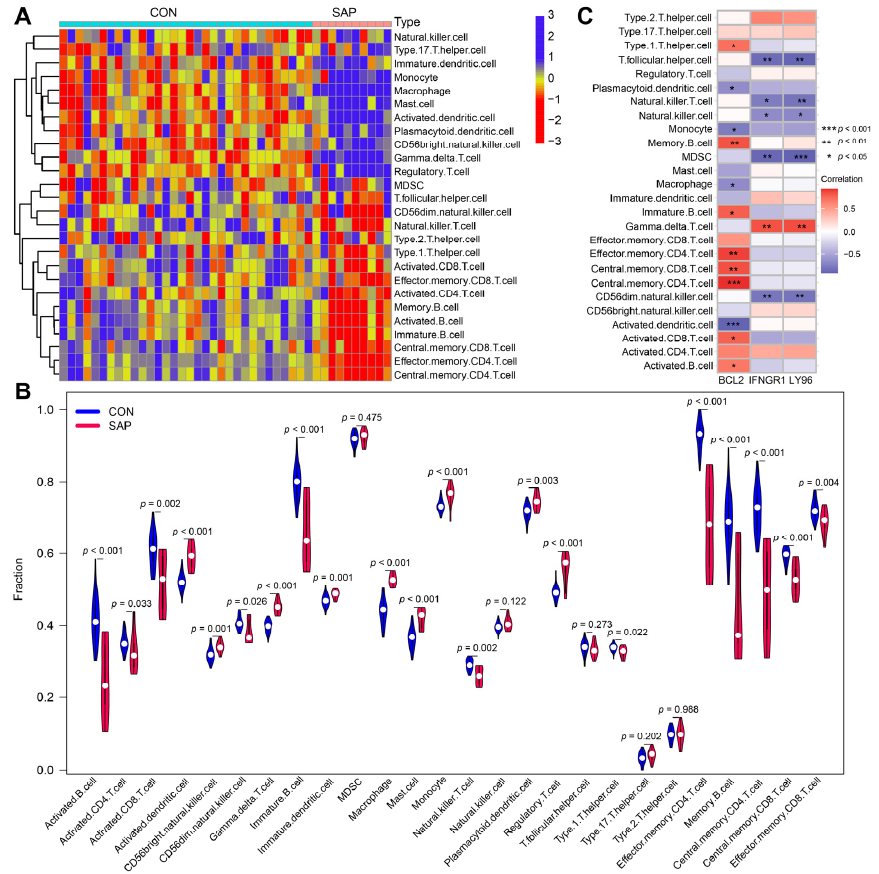
Figure 6. Analysis of immune in fi ltration in SAP patient samples and its correlation with hub genes using ssGSEA. ( A ) Heat map showing the immune scores of 26 immune cells. Red indicates immune cell in fi ltration and blue indicates suppressed immune cells. ( B ) Violin plot showing immune scores of 26 immune cells in SAP patients and healthy controls. ( C ) Correlation between immune cell in fi l- tration and three hub genes. * p < 0.05, ** p < 0.01, *** p < 0.001.